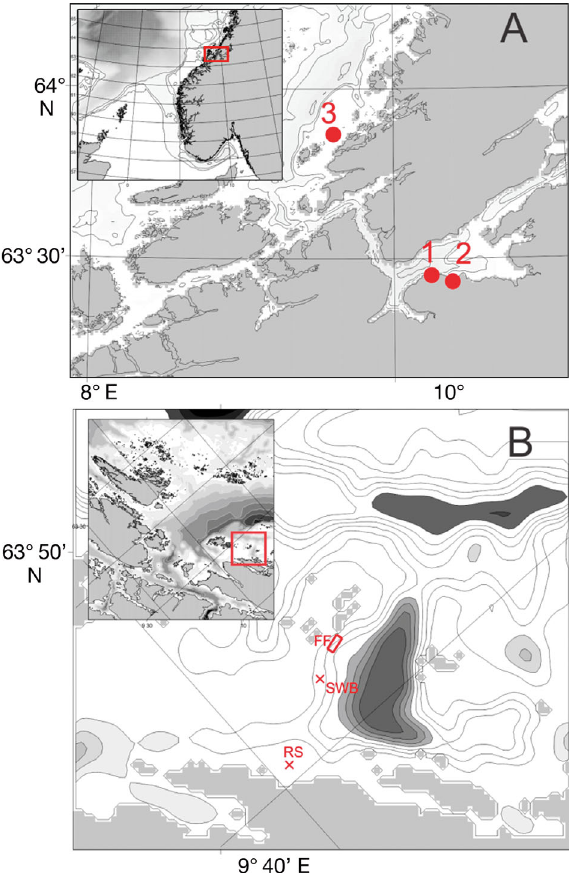
Fig. 1. (A) Map of the coast of southern Norway (inset) indi- cating the region of the experimental work and the model setups. 1: site (Storsteinan, 63°27’N, 10°15’ E) where Saccha- rina latissima sporophytes for the mesocosm basin experi- ment were collected; 2: location of Trondheim Biological Station/NTNU, Trondheim, the site of the mesocosm experi- ment; 3: location of the ACE fish farm at Tristeinen (63° 52.250’N, 9°37.022’E), where the integrated multi-trophic aquaculture field experiment was undertaken. The main map is part of the model domain in 800 m horizontal resolu- tion for the coast of mid-Norway used for nesting to the 160 m model grid. (B) Model grids in 160 m horizontal reso- lution. FF: fish farm; RS: reference station; SWB: Seawatch Buoy used for current measurements. Note the rotation of the model grids in Panel B relative to those in Panel A. The grey curves indicate